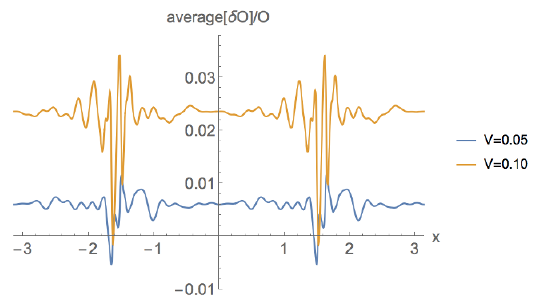
Figure 6 . Change of the one-point function due to the presence of disorder as a function of x for di(cid:11)erent disorder amplitudes. We plot (cid:14) h O i = h O i 0 = 1 (cid:0) (cid:17) , where (cid:17) is de(cid:12)ned in (4.5).